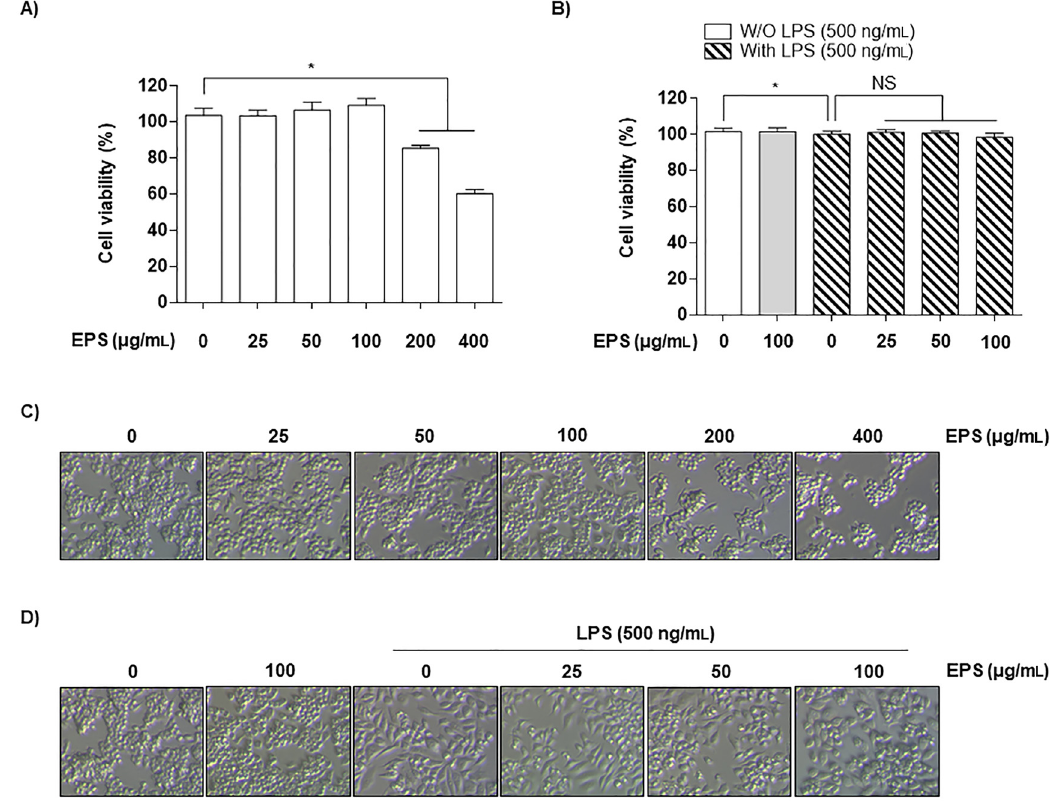
Figure 2: Effect of EPS on the viability of RAW 264.7